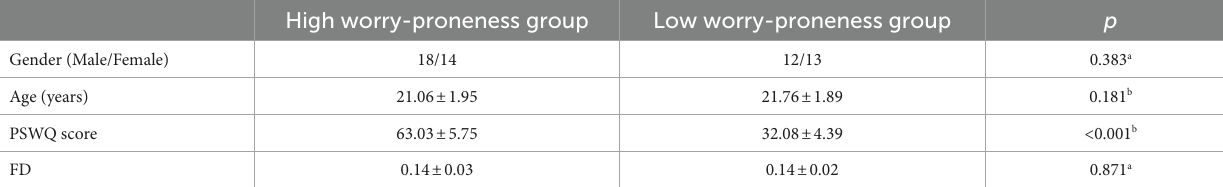
TABLE 1 Participant fundamental information. High worry-proneness group Low worry-proneness